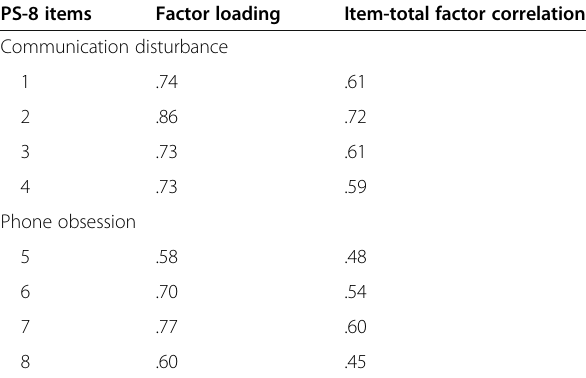
Table 4 Standardized factor loadings for the PS-8, corrected item-total correlations, and McDonald ’ s omega ( N = 391) PS-8